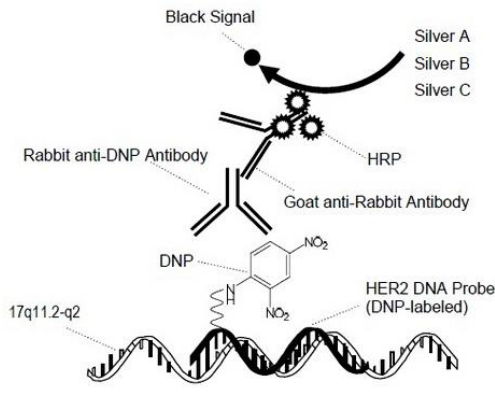
Fig. 2. Silver DNA In Situ Hybridization Reactions for HER2 DNA